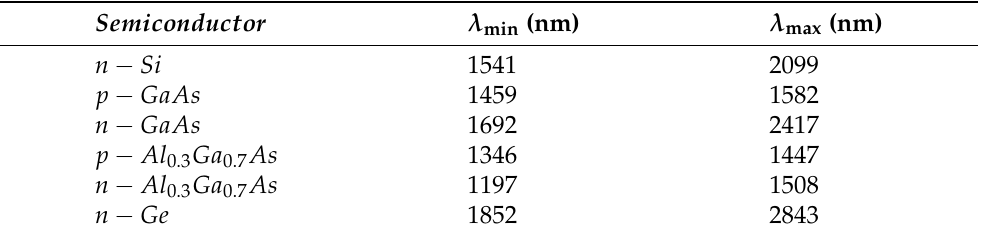
Table 3. Range of wavelengths in which the R / NEP ratio of the Schottky photodetectors (PDs) can be maximized by applying a reverse bias up to 20